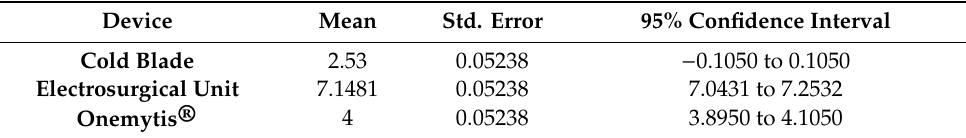
Table 1. Epidermal Score.